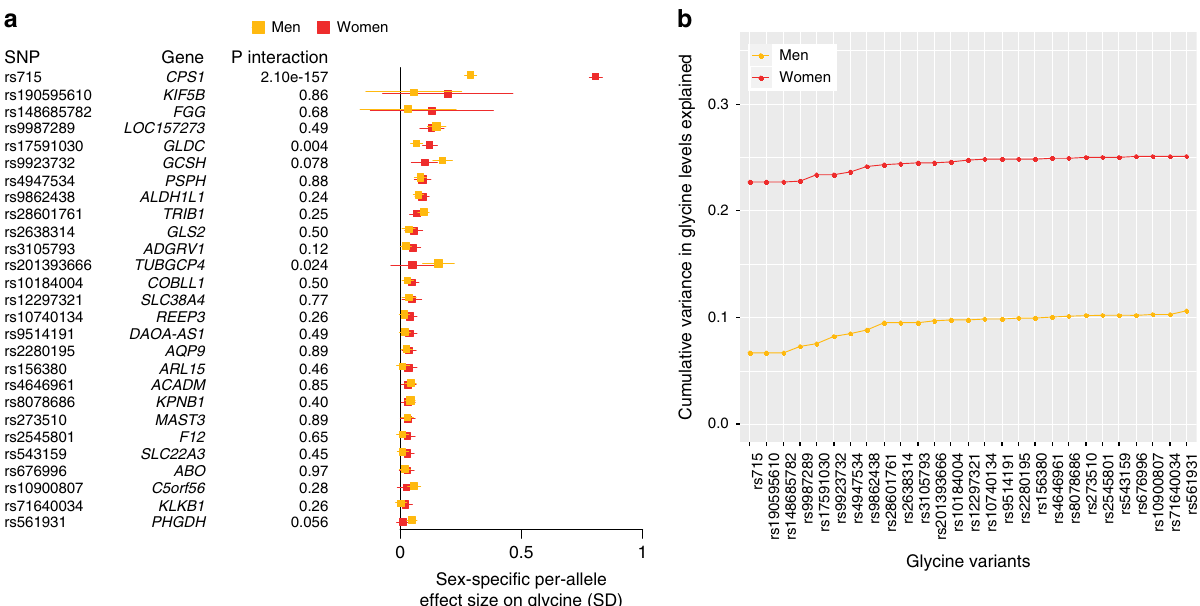
Fig. 3 Sex-speci fi c effect sizes and cumulative variance explained by lead SNPs at the 27 genetic loci for glycine. a Sex-speci fi c effect sizes of lead SNPs at the signi fi cant loci for glycine levels based on a meta-analysis of the Fenland, EPIC-Norfolk and INTERVAL studies, including 30,226 men and 31,957 women. b Cumulative variance in glycine levels explained ( r 2 ) by lead SNPs at all 27 loci in men ( N = 5086) and women ( N = 5706) of the EPIC-Norfolk